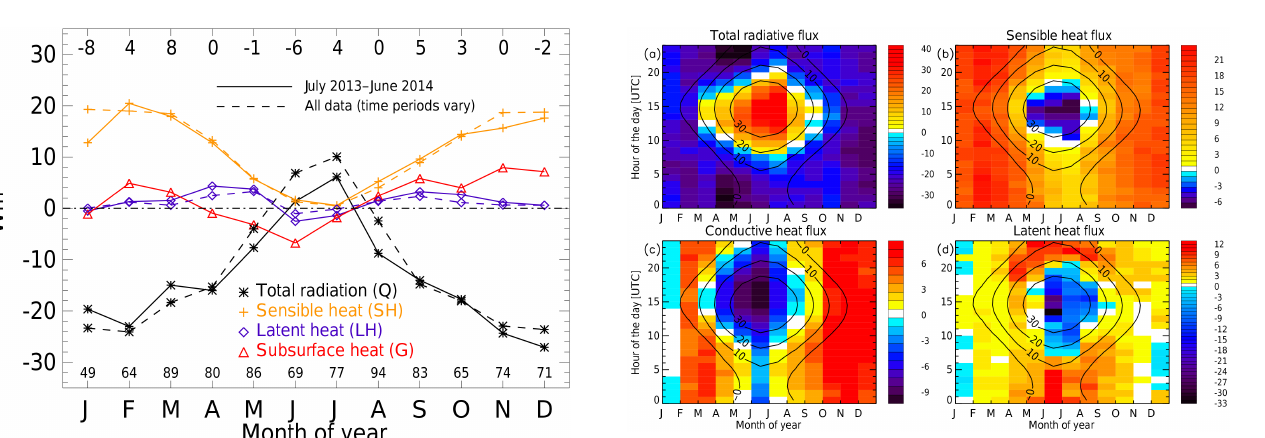
Figure 2. Monthly mean values of the four SEB terms for the period July 2013–June 2014. The values at the top of the figure are the monthly residual of the SEB (Wm − 2 ). The values at the bottom of the figure are the percentage of the month for which all four SEB terms are available.